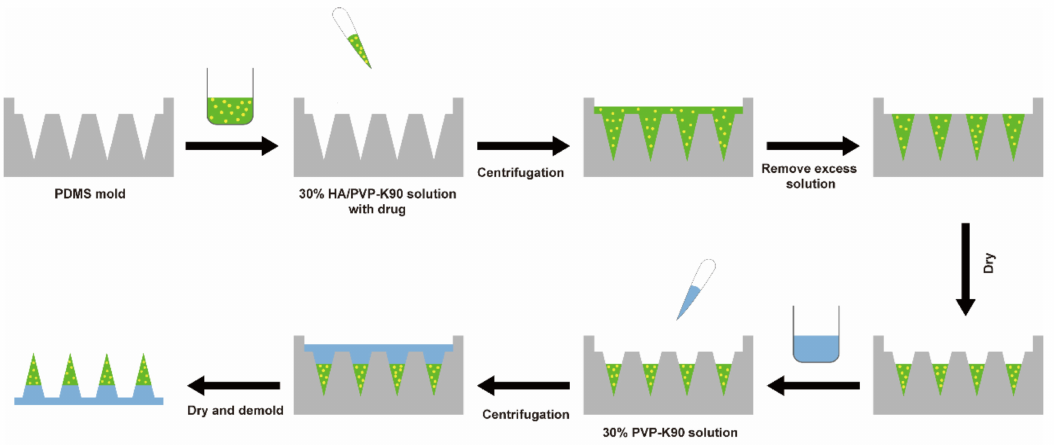
Figure 1. Schematics of the fabrication process of propranolol hydrochloride loaded